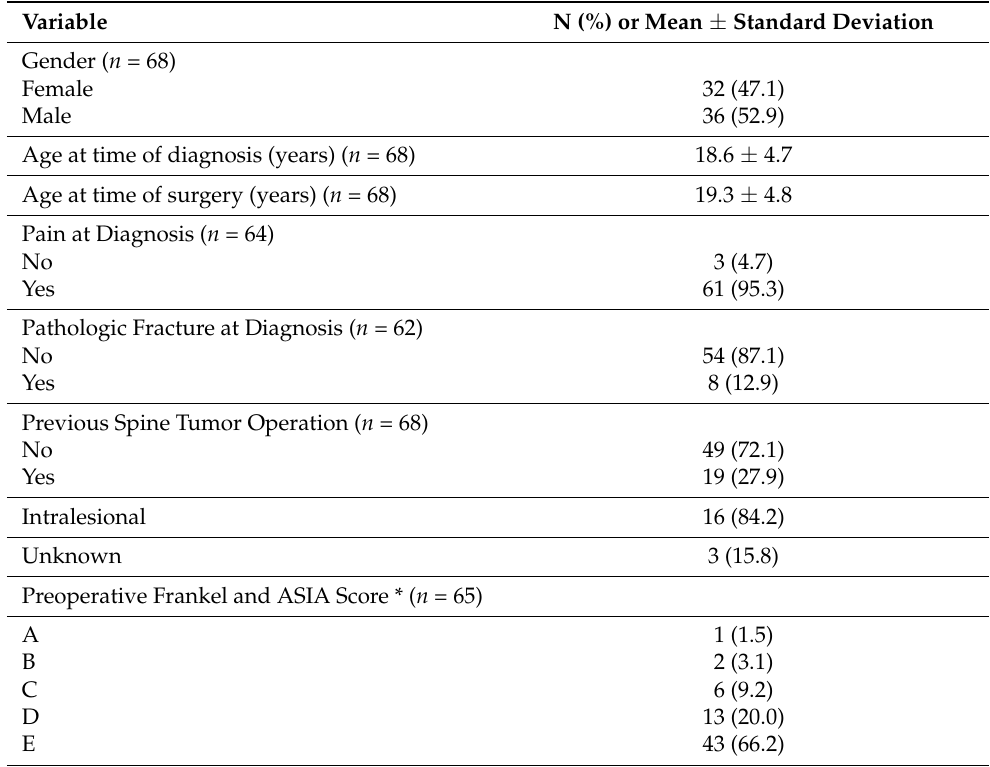
Table 1. Summary of patient demographic and clinical